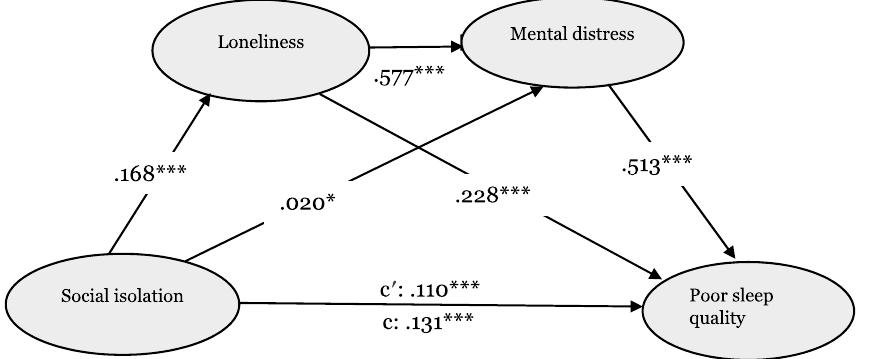
Figure 5. A serial multiple mediation model of the association between social isolation and poor sleep quality (e.g., not feeling rested after waking up from sleep in the morning) through loneliness and mental distress. Path unstandardized coefficients are depicted. C ′ denotes the direct effect of social isolation on impaired sleep; c denotes the total effect of social isolation on impaired sleep via mediators. * p < 0.05, *** p < 0.001.